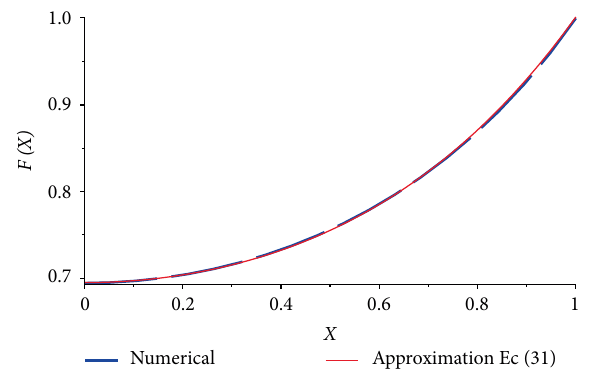
Figure 3: Comparison between numerical solution of (13) and approximation (31) for 휀 =